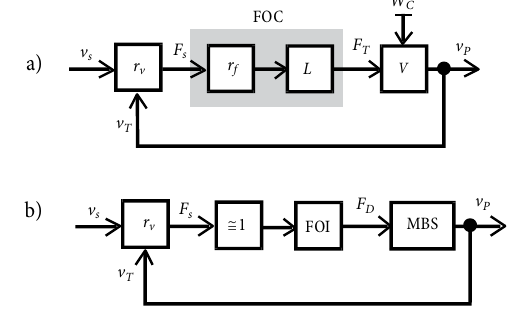
driveFig. 6. The control system: a – linear motor; b – substitute (simulation model)